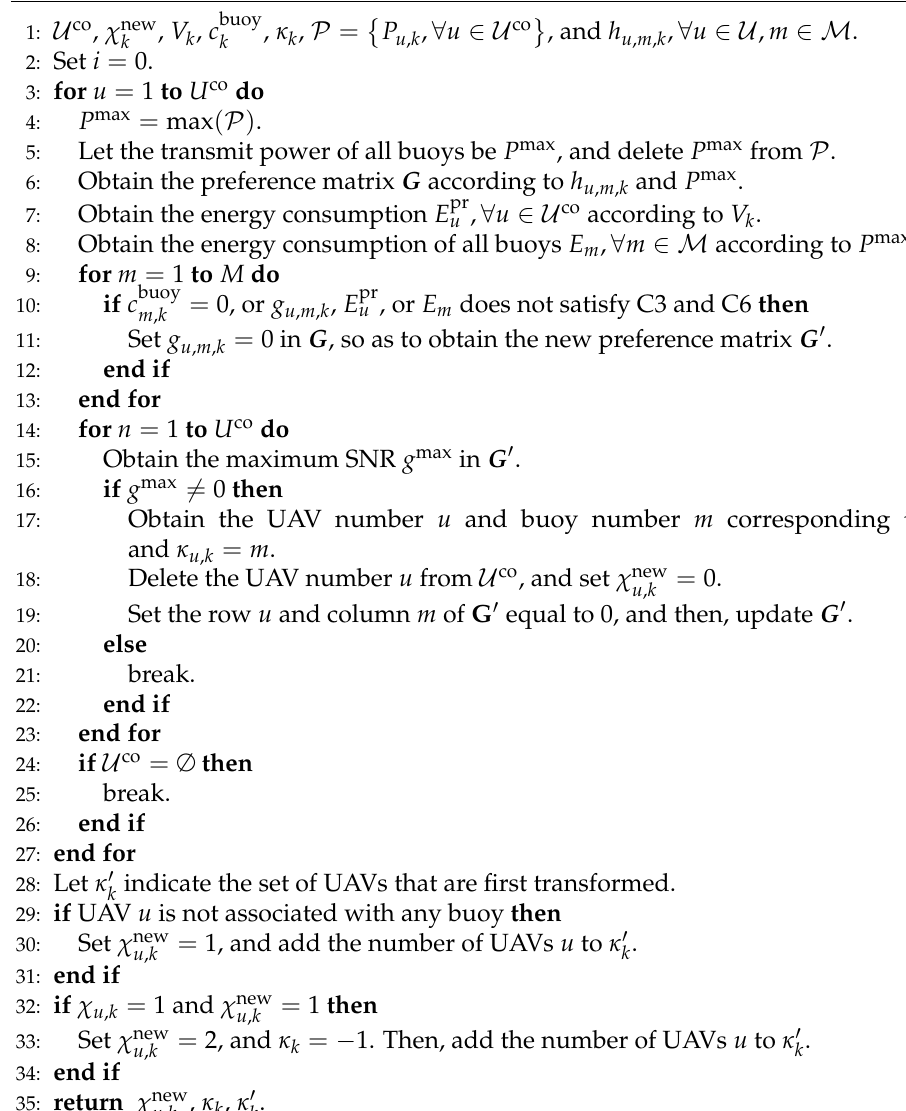
Algorithm 2 SMP-based buoy-UAV association algorithm